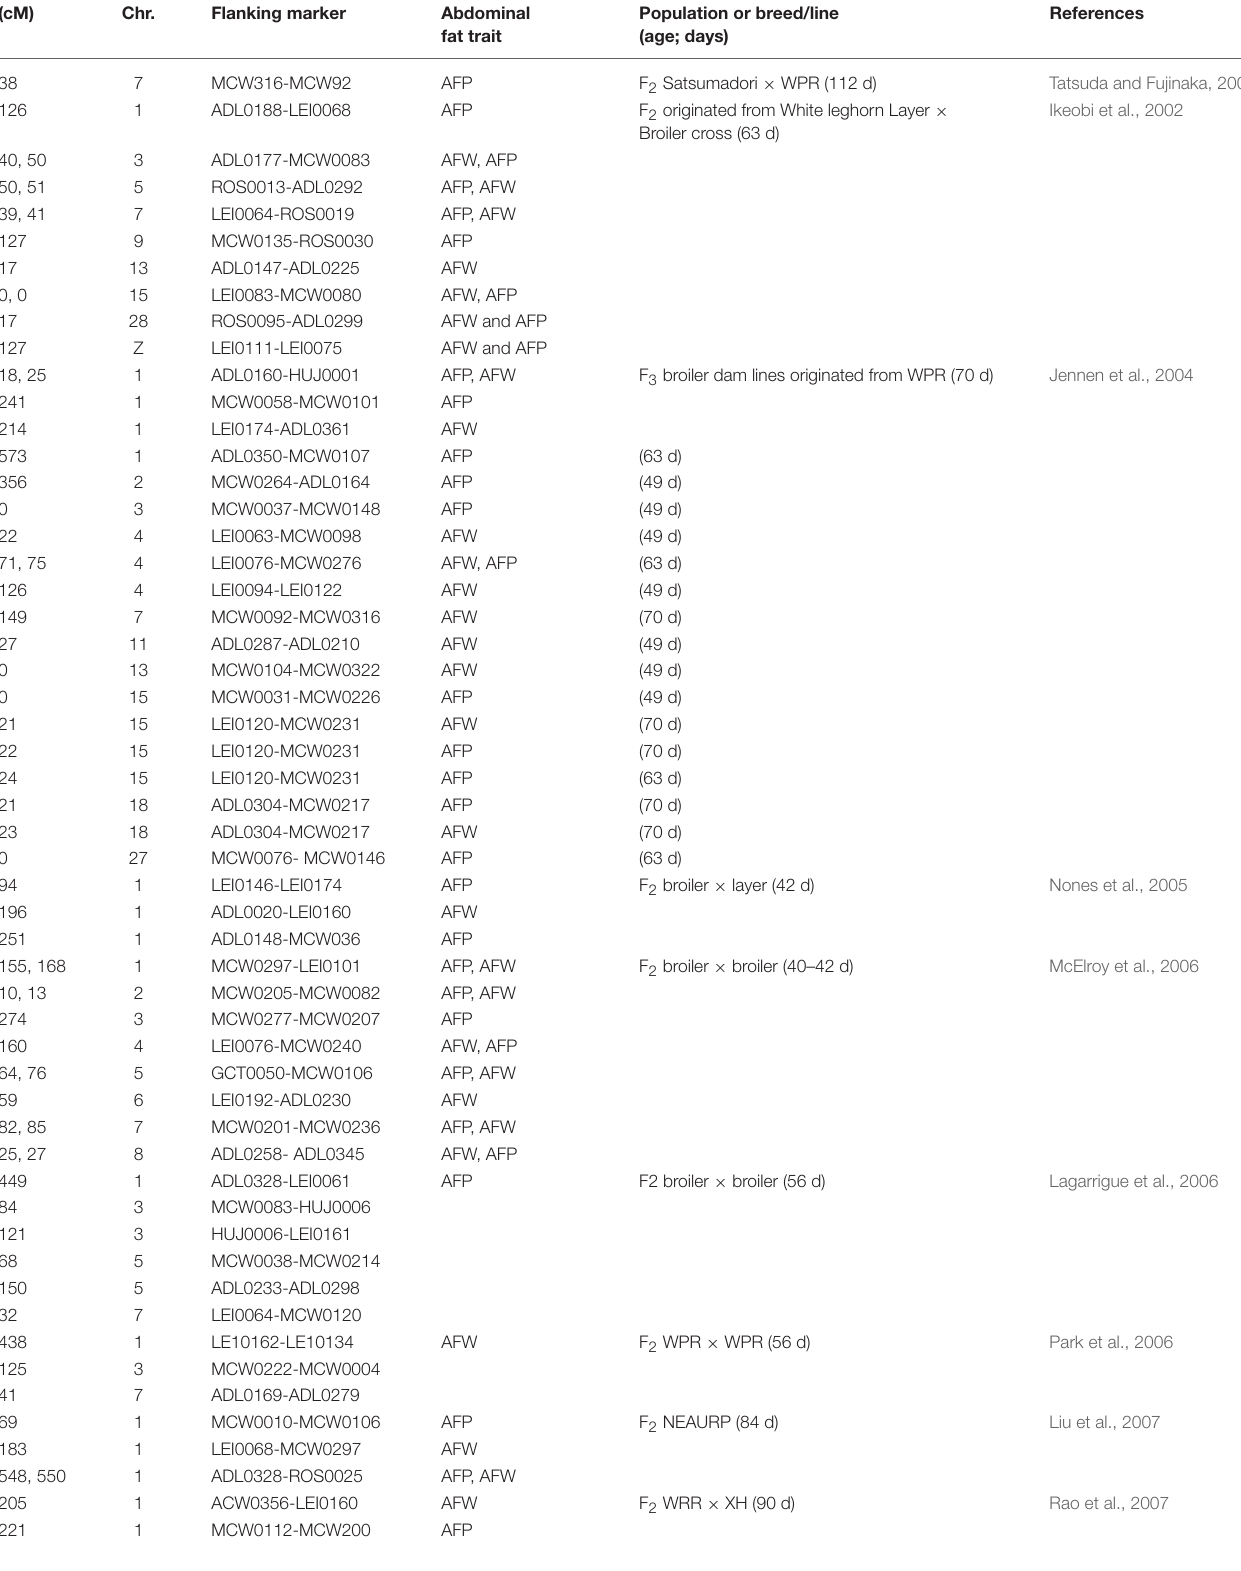
TABLE 1 | QTL positions significantly controlling abdominal fat deposition in chicken. (cM) Chr. Flanking marker Abdominal